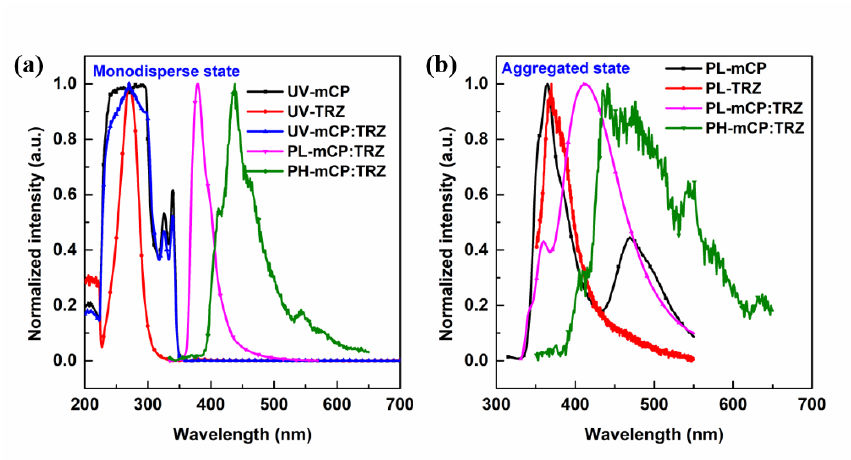
Figure 3. ( a ) Normalized absorption spectra, fluorescence spectra and low temperature phospho- rescence spectra (after delay of 100 µ s) of mCP, TRZ and mCP:TRZ in toluene (10 − 5 M). ( b ) The normalized fluorescence spectra and low-temperature phosphorescence spectra (after delay of 100 µ s) of mCP, TRZ and mCP:TRZ in neat solid films.